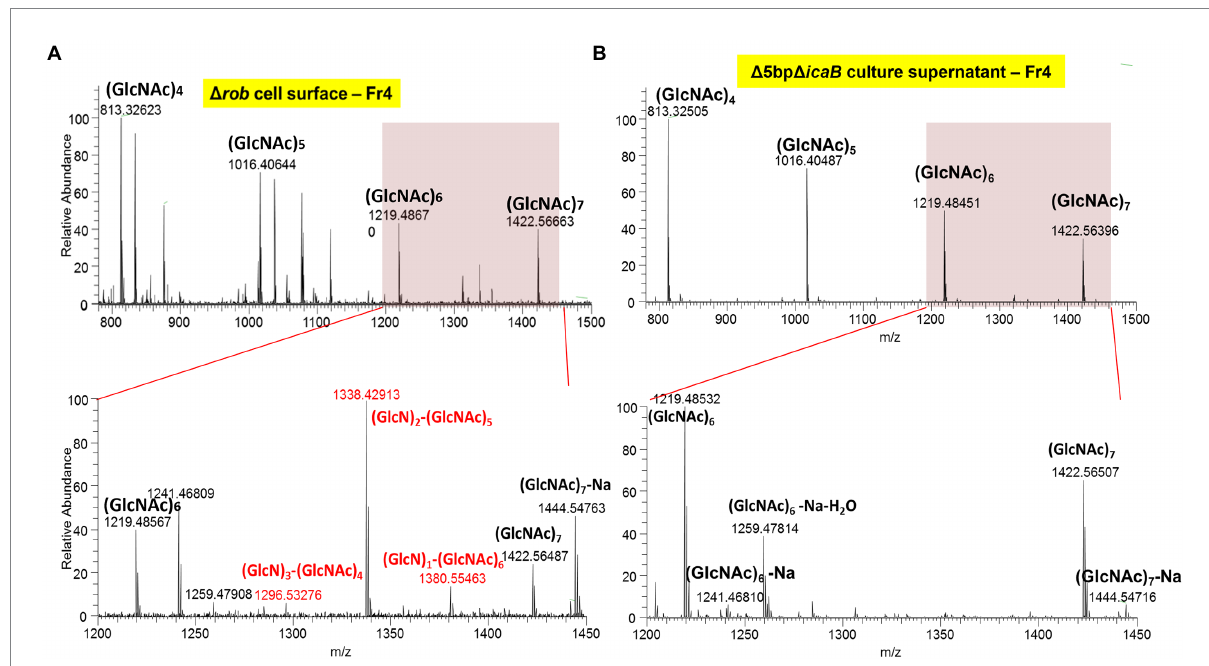
FIGURE 9 The typical ESI positive ion mass spectrum of PIA fractionated by GPC, showing the major mass differences to be deacetylation of poly- N -acetyl- D-glucosamine polymer. Typical ESI-positive ion mass spectrum of PNAG from FK300 Δ 5bp Δ icaB fractionated using GPC. Samples of cell surface FK300 Δ rob (A) and culture supernatant FK300 Δ 5bp Δ icaB (B) from the collected fraction by GPC were analyzed using ESI-MS. MS analyses of authentic PNAG (A) showed fragmentation of polysaccharide homopolymers resulting in a series of ESI-MS of m/z = 203 Da, which corresponded to GlcNAc. Besides these spectra, several peaks defecting of m/z = 42 Da, which corresponded to deacetylation of [GlcNAc] polymer were observed in FK300 Δ rob (A) . By contrast, the culture supernatant of autoaggregation inducing strain FK300 Δ 5bp Δ icaB (B) contained non deacetylated [GlcNAc] polymer. N -acetyl-D-glucosamine is expressed as GlcNAC, Glucosamine as GlcN. WT; wild type strain FK300.